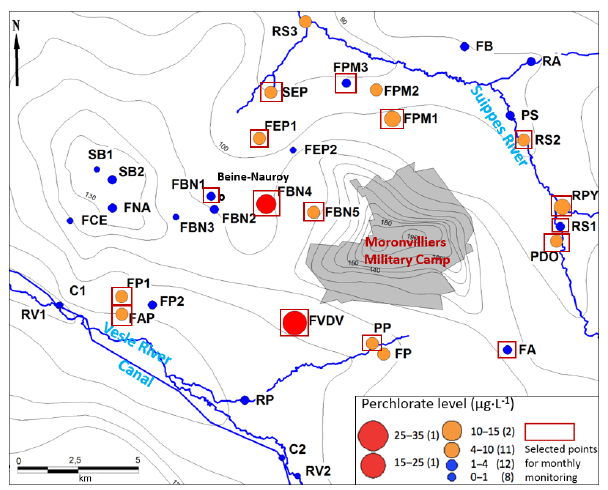
Figure 2. Perchlorate levels in waters in June 2017 and selected sampling points for the monthly